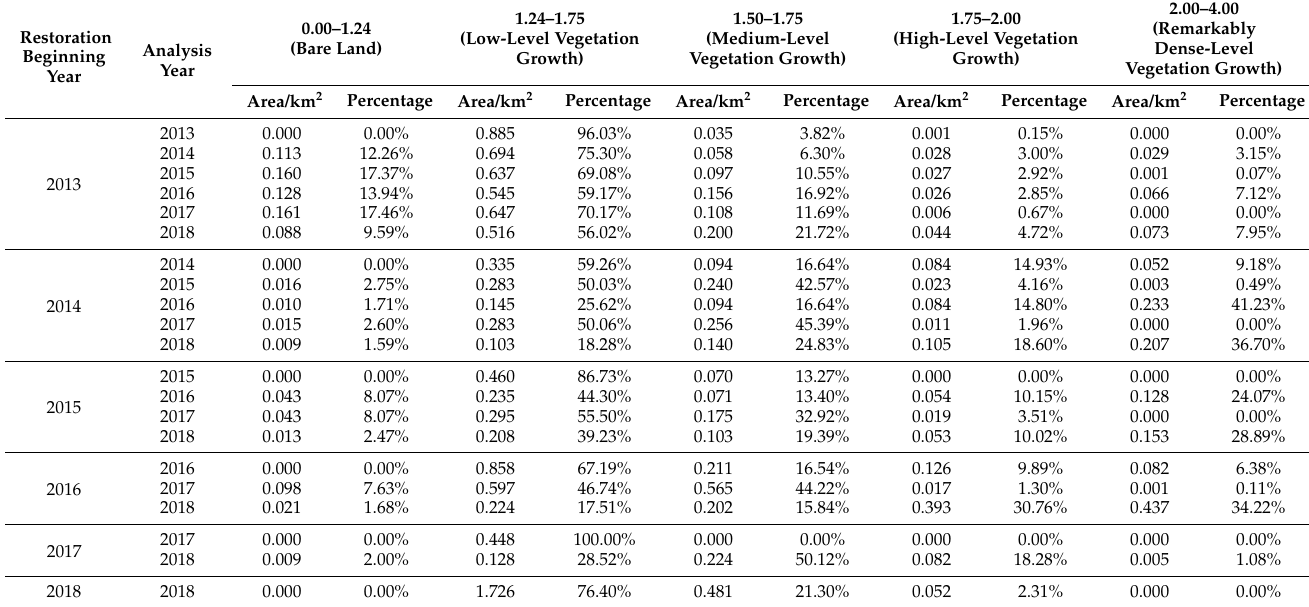
Table A3. Interannual vegetation growth of restoration vegetation of each year from 2013 to 2018 in the study region.